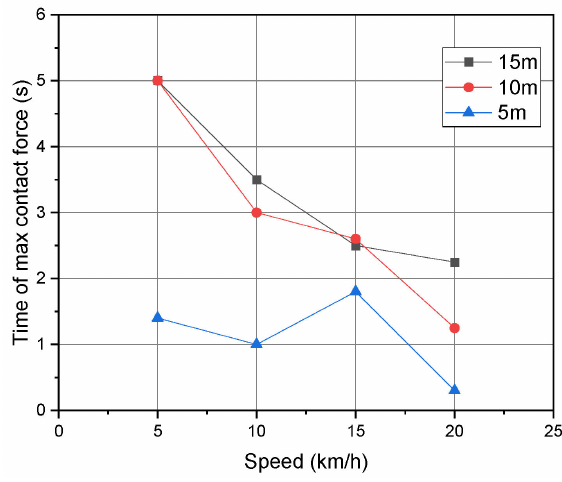
Figure 17. Time of maximum contact